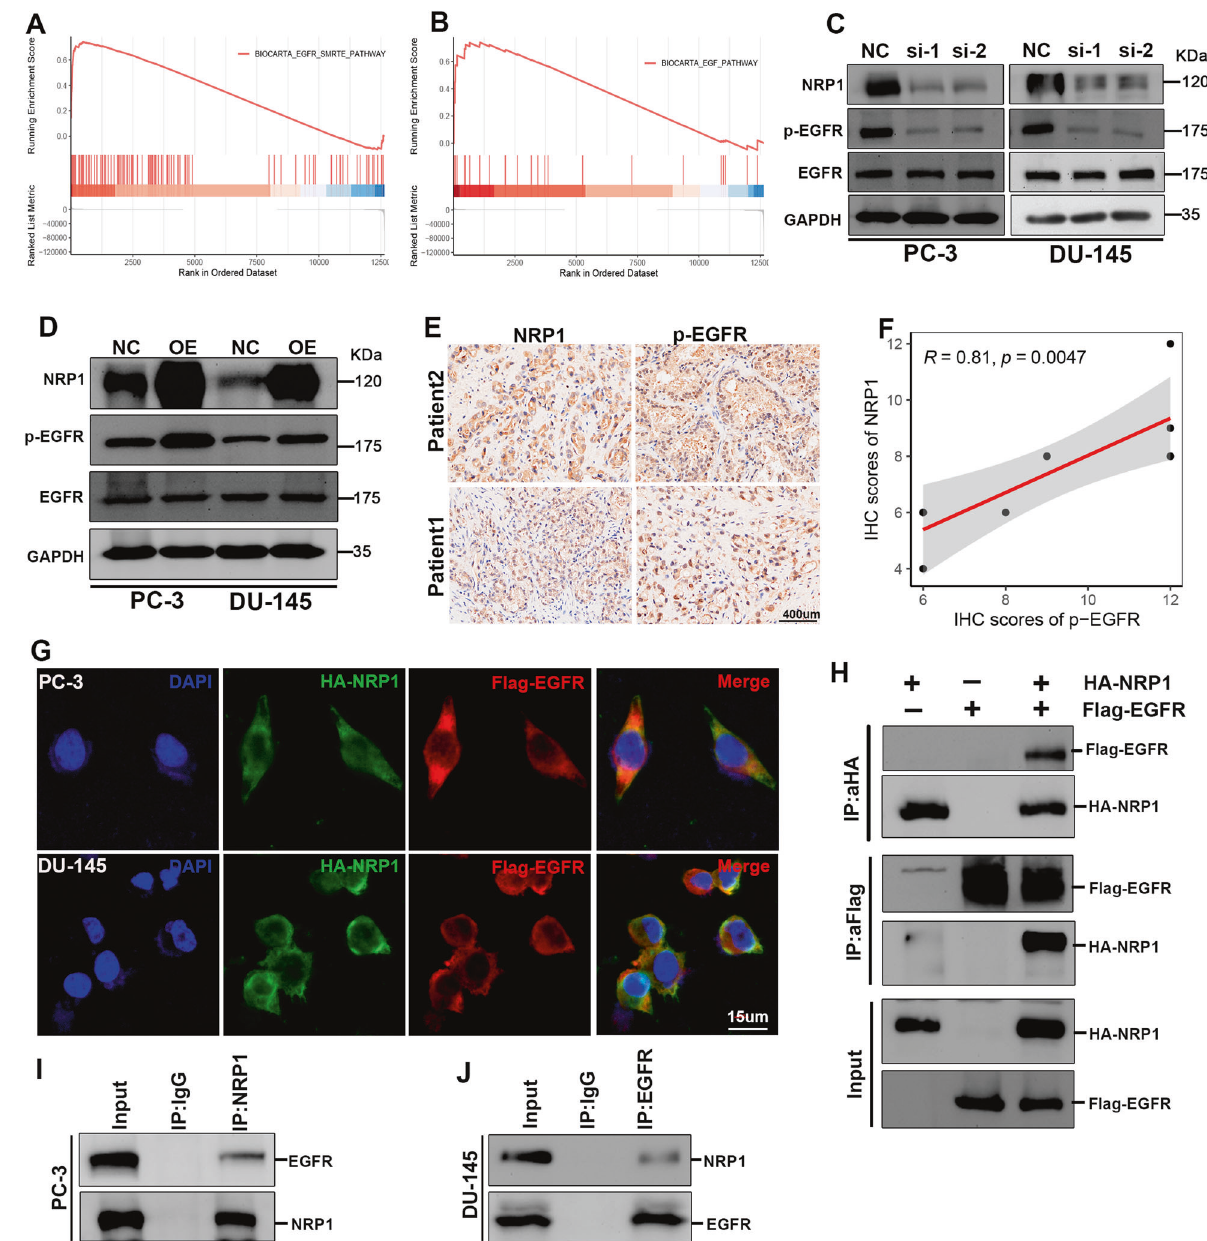
Fig. 5 NRP1 interacts with EGFR and induces EGFR phosphorylation. A , B GSEA of TCGA-PRAD shows NRP1 is positively related to the EGFR pathway. C , D Immunoblot assay elucidates that NRP1 depletion attenuates EGFR phosphorylation level, while ectopic overexpression of NRP1 promotes EGFR phosphorylation level. E , F IHC assay and the correlation analysis represent that NRP1 protein is positively correlated with the expression of phosphorylated EGFR protein in PCa tissues (scale bar = 400 μ m). G NRP1 (green) and EGFR (red) co-localization is examined by the immuno fl uorescence assay (scale bar = 15 μ m) and the nucleus is indicated by DAPI (blue) staining. H Exogenous Co-IP assay represents NRP1 could interact with EGFR in 293T cells. I , J Endogenous Co-IP assay proves NRP1 could interact with EGFR in PC-3 and DU-145 cells. Statistical signi fi cance was assessed using a two-tailed t reported the AKT pathway to be the downstream signaling DU-145 cells compared to controls (Fig. 7A). The KEGG analysis pathway of EGFR, it was hypothesized that NRP1 played an based on the TCGA-PRAD dataset also indicated enrichment of the oncogenic role through EGFR/AKT signaling axis in PCa. Further, AKT pathway in the high NRP1 expression group (Supplementary the role of EGFR in NRP1-induced PCa progression was evaluated Fig. S4). Further, the key proteins in AKT pathways were detected by using ge fi tinib, a speci fi c inhibitor of EGFR, in NRP1- after overexpression or knockdown of NRP1. It was observed that overexpressed PCa cells to ascertain the changes in cell the phosphorylation of AKT, GSK3 β , and mTOR was down- proliferation and migration. It was observed that ge fi tinib regulated in NRP1-depleted PCa cell lines. Contrarily, ectopic obviously retrieval the promotion of proliferation and migration overexpression of NRP1 enhanced the phosphorylation of AKT, in NRP1- overexpressing PCa cells (Fig. 7D – K). Immunoblot assay GSK3 β , and mTOR in PCa cells (Fig. 7B, C). As a previous study